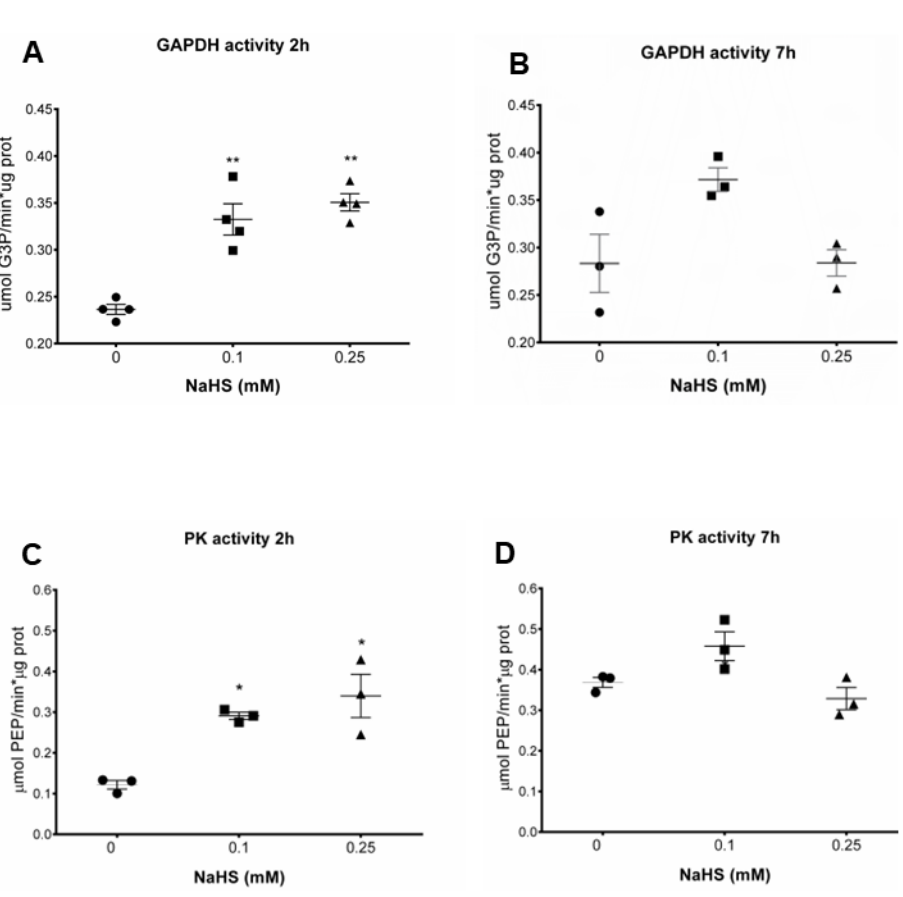
Figure 4. H 2 S increases the activity of GAPDH and pyruvate kinase two hours after stimulation. ( A ) 304 Yeast cell cultures in exponential phase were treated with NaHS 0.1 and 0.25 mM. Two hours later, 305 whole-cell extracts were used to measure GAPDH activity in vitro at 37 °C. One-way ANOVA ** p 306 < 0.0001. ( B ) Yeast cell cultures in exponential phase were treated with NaHS 0.1 and 0.25 mM. Seven 307 hours later, whole-cell extracts were used to measure GAPDH activity in vitro at 37 °C. ( C ) Yeast 308 cell cultures in exponential phase were treated with NaHS 0.1 and 0.25 mM. Two hours later, whole- 309 cell extracts were used to measure pyruvate kinase activity in vitro at 37 °C. ( D ) Yeast cell cultures 310